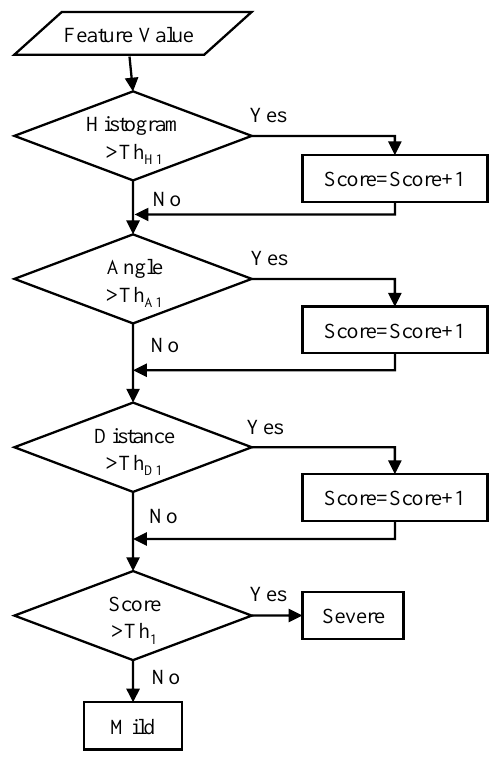
Figure 8. Severity measurement algorithm for essential tremors ( ET) patients.